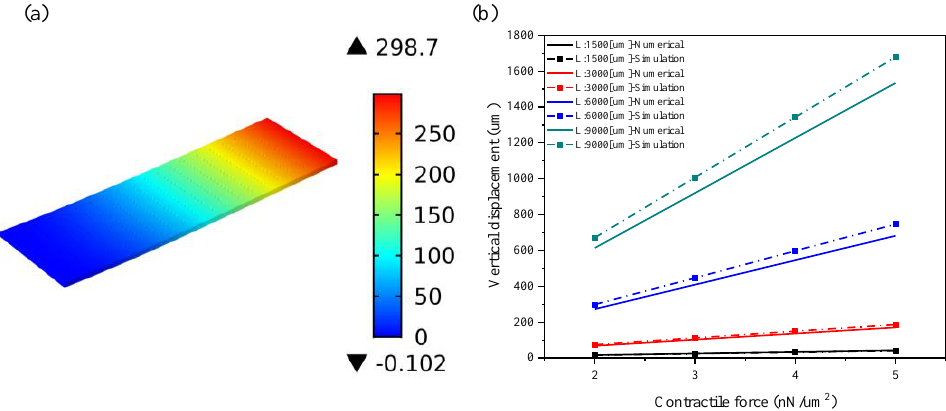
Figure 4. The numerical and simulation results of the maximum displacements at the free end of the perforated microcantilever under different conditions: ( a ) the vertical displacement plot of the perforated microcantilever when the contractile force is 2 nN/μm 2 ( L is 1500, 3000, 6000, and 9000 μm, respectively; d is 60 μm, q 1 is 300 μm; and q 2 is 100 μm); ( b ) the effect of the contractile force on the maximum displacements of the perforated microcantilever with different sizes ( L is 1500, 3000, 6000, and 9000 μm, respectively; the aspect ratio is 3:1; d is 60 μm; q 1 is 300 μm; q 2 is 100 μm; and t f is 100 um).